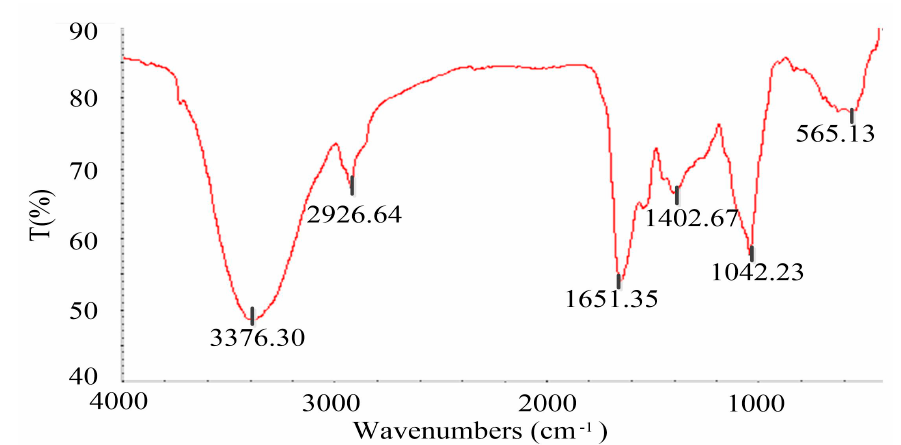
Figure 4. Ultraviolet-visible absorption spectroscopy (UV-VIS) spectrum of RF4. The aqueous solutions of RF4 was 1 mg/mL.